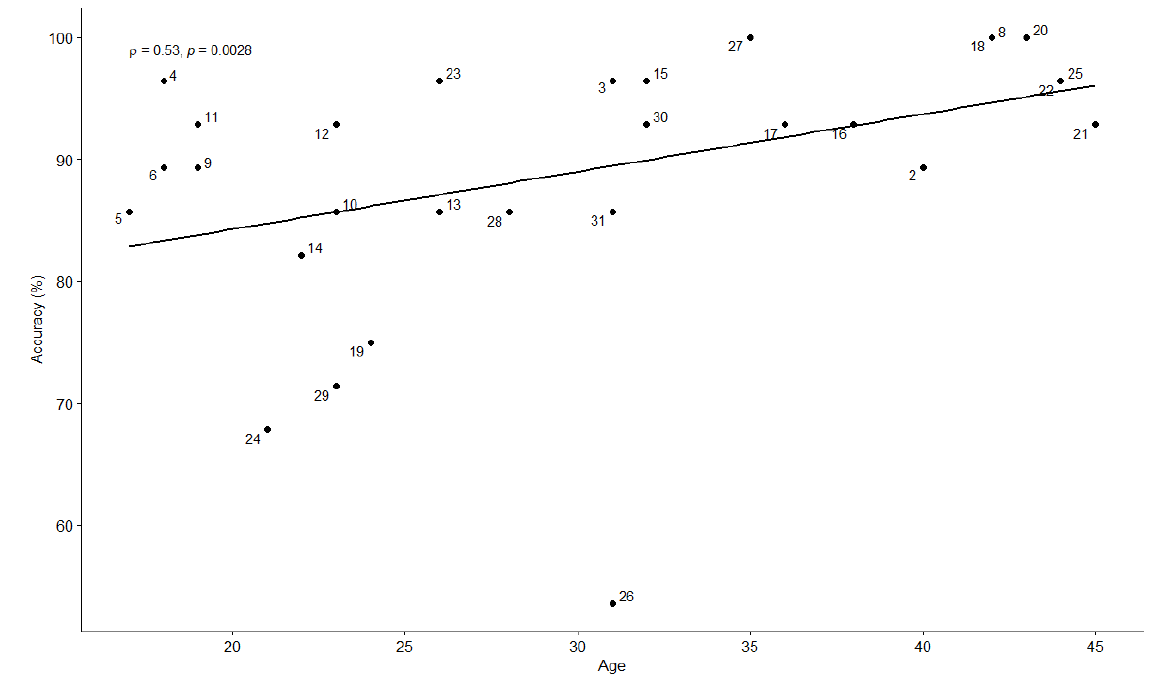
Figure 4. Scatterplot displaying the relationship between age and percentage accuracy in the identification of the contrast between /c/ and / ʧ /. Spearman’s correlation coefficient is indicated by ρ. Corresponding p -values are found to the right of each coefficient value.